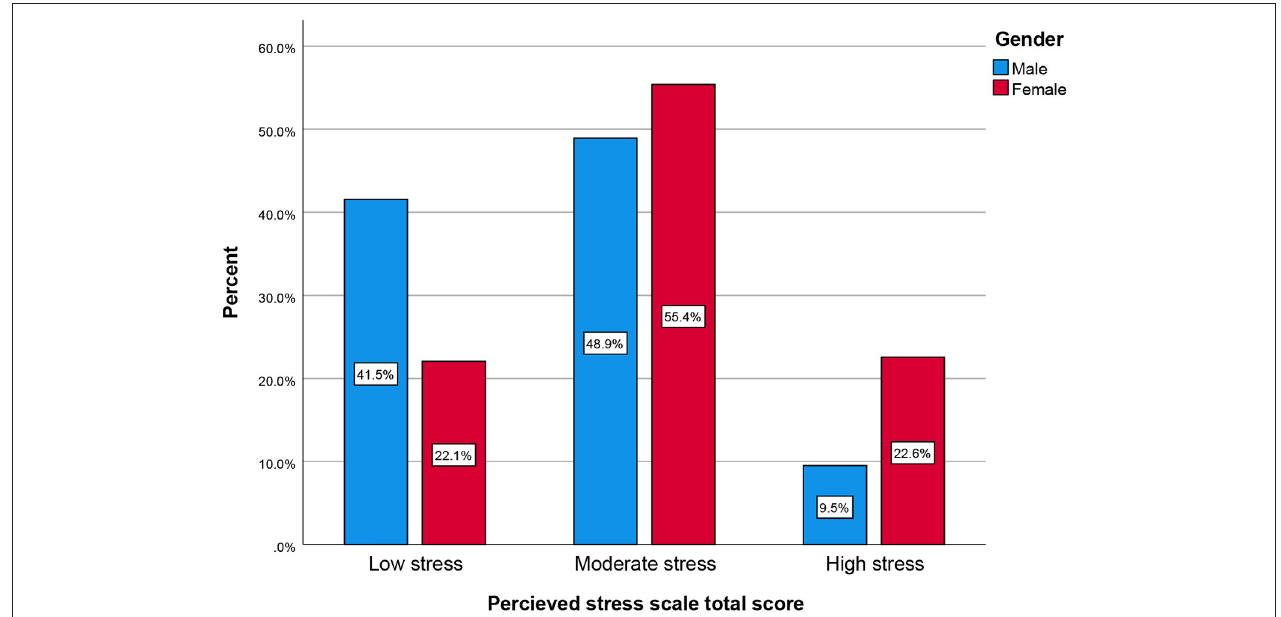
FIGURE 1 | Perceived stress total score by gender (cluster bar count).